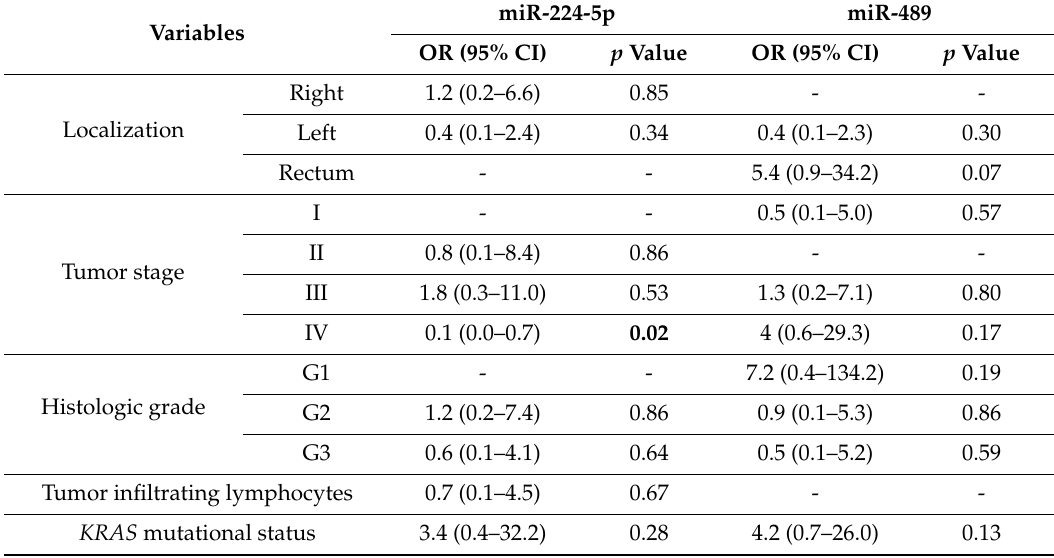
Table 3. Univariate analysis to assess the relationship between miR-224-5p and miR-489 expression level deregulation, and clinic-pathological and molecular